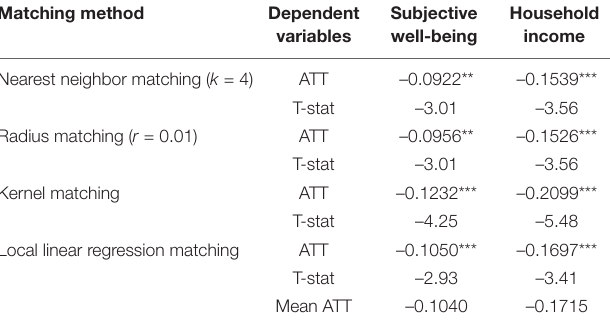
TABLE 5 | Comparisons of average treatment effect